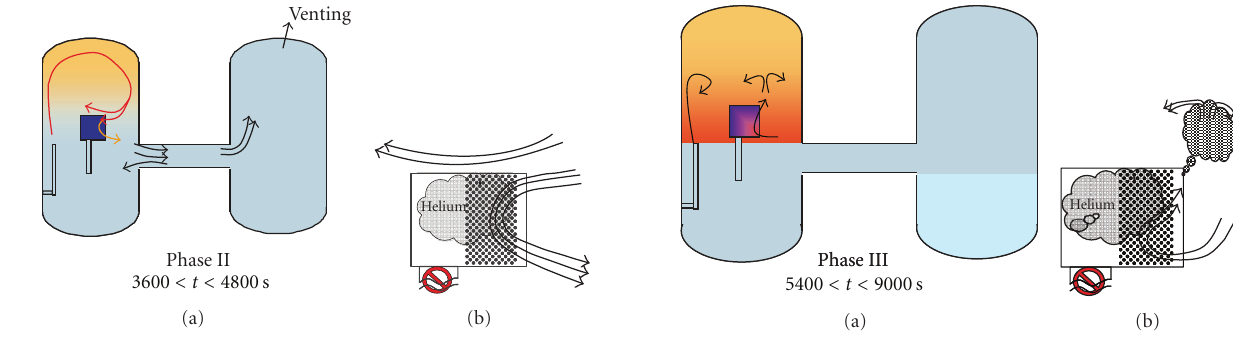
Figure 16: Suggested flow pattern for 5400 < t < 9000